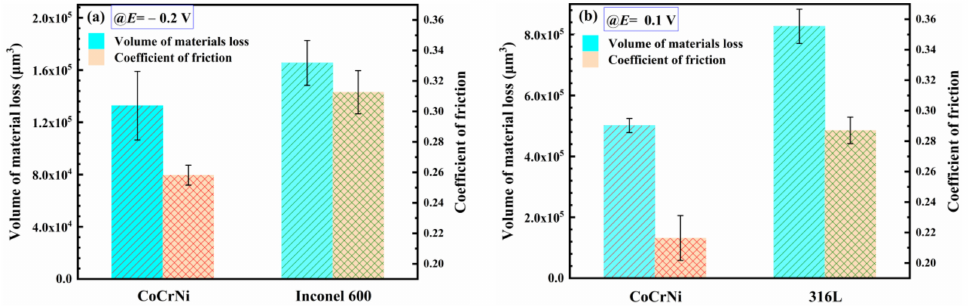
Figure 4. Comparison of friction coefficient and wear volume of CoCrNi in 3.5 wt.% NaCl solution with ( a ) Inconel 600 at − 0.2 V and ( b ) 316L stainless steel at 0.1 V. Sliding speed and time are 1 mm/s and 40 min,